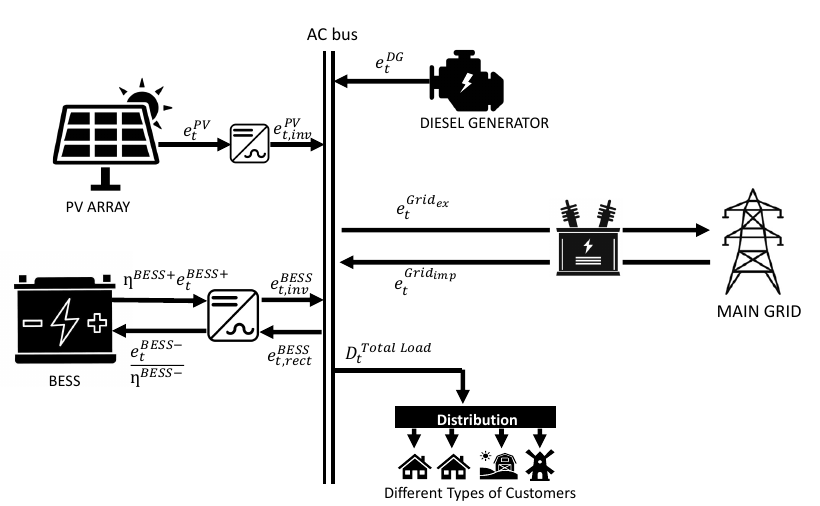
Figure 2. Topology of a mini-grid under the